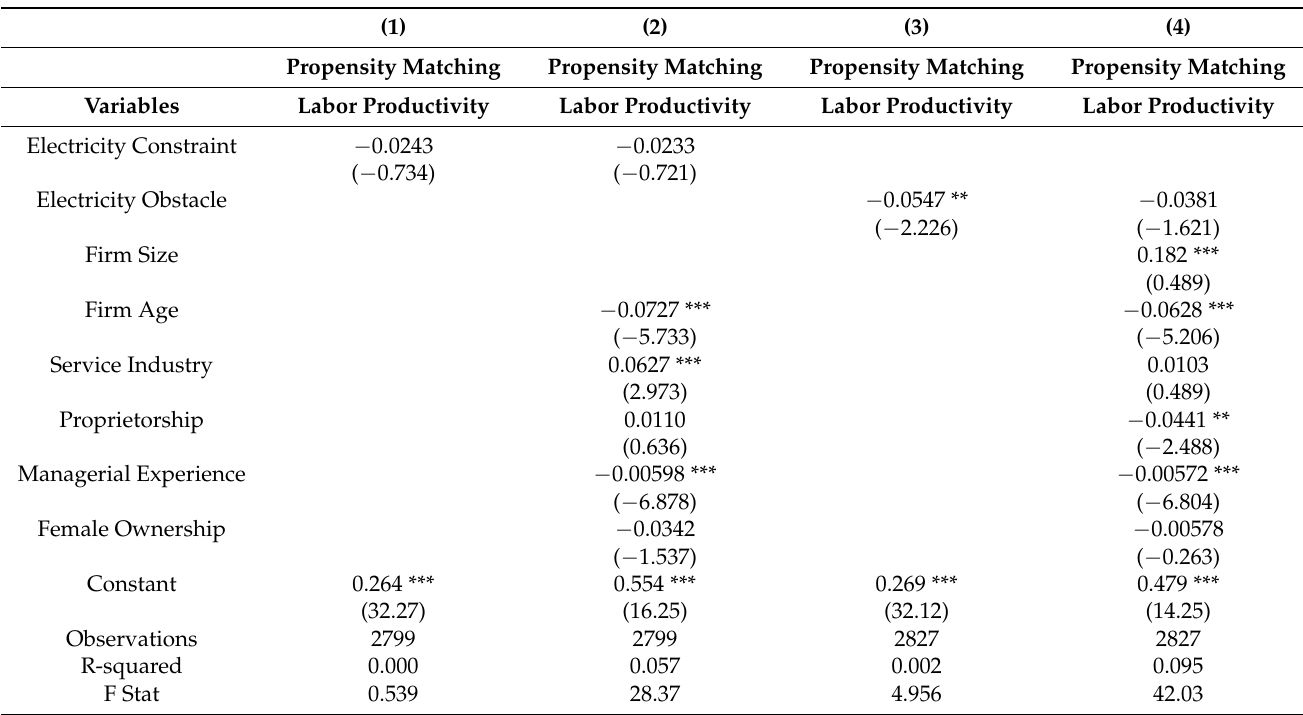
Table 7. Probit regression of the matched sample for access to